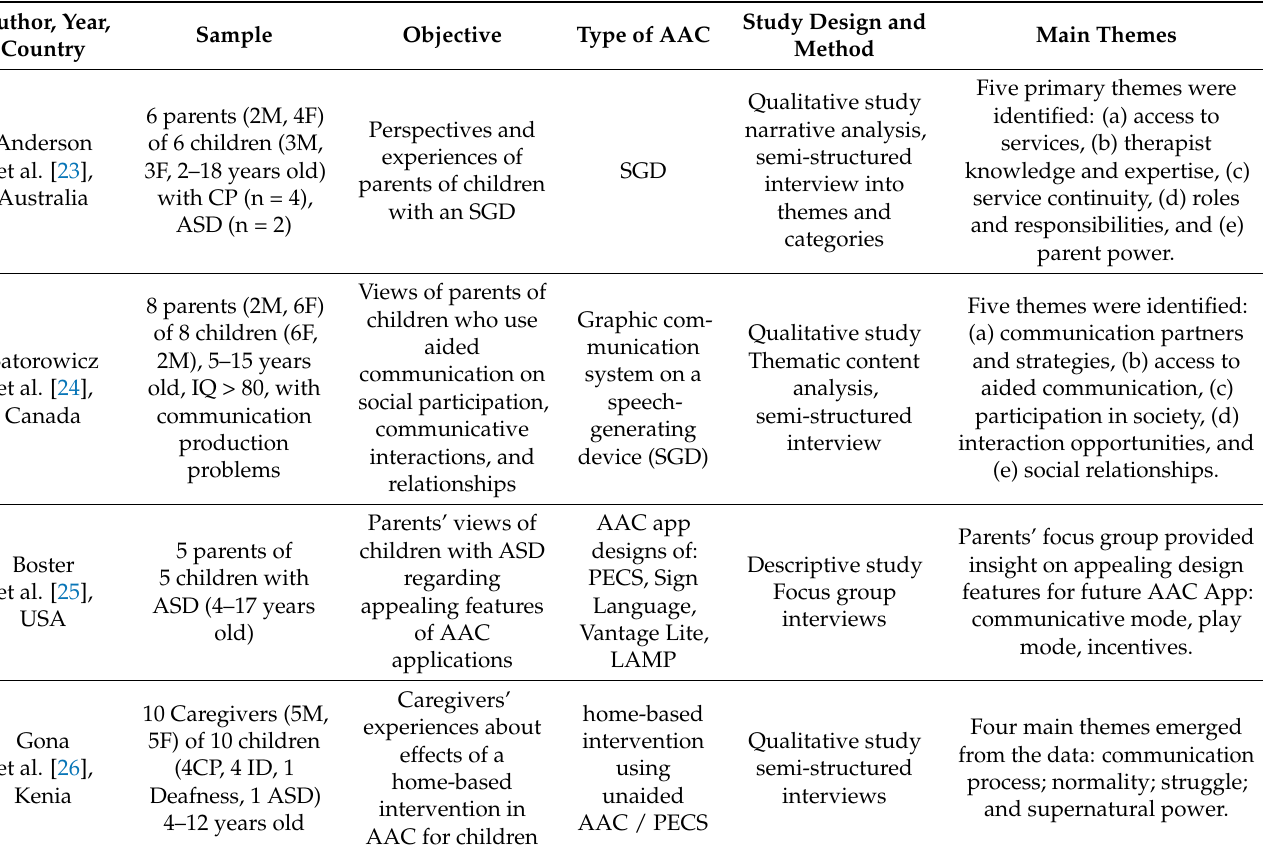
Table 1. Main characteristics of the studies (N =